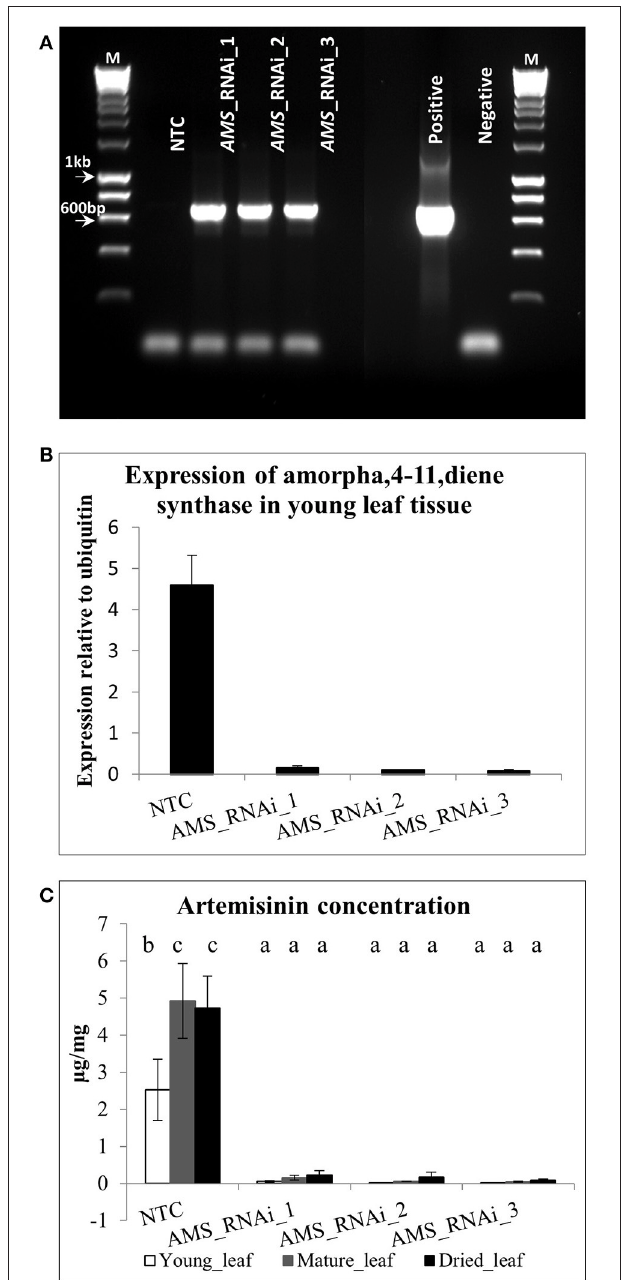
FIGURE 3 | (A) PCR results for NPTII primers M − 1kb hyperladder TM (Bioline), (B) Q-RT-PCR of AMS gene expression and (C) Artemisinin concentration ( µ g/mg extracted dry weight) in young and mature leaves and dried pooled leaf material for the NTC and AMS silenced lines. Error bars ± SD (NTC— n = 6, AMS _RNAi lines— n = 3). Letters represent Bonferroni test results after ANOVA, groups not sharing letters indicate statistically significant differences ( p ≤